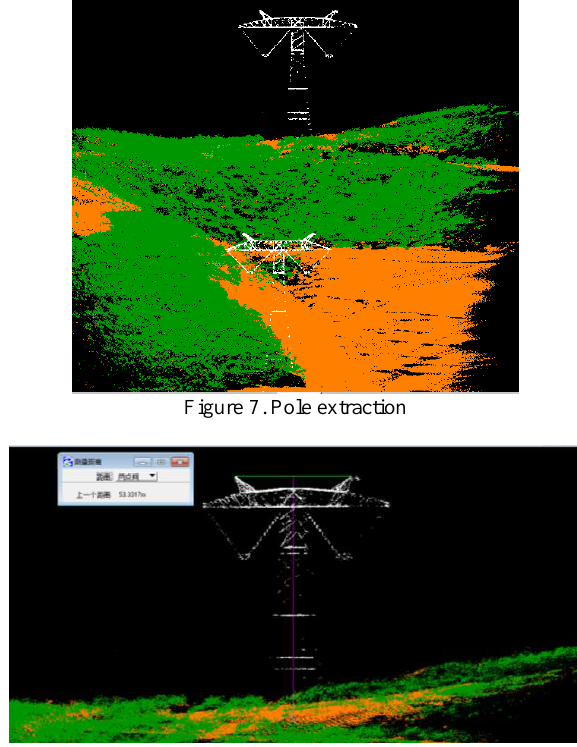
Figure 8. Pole height measurement